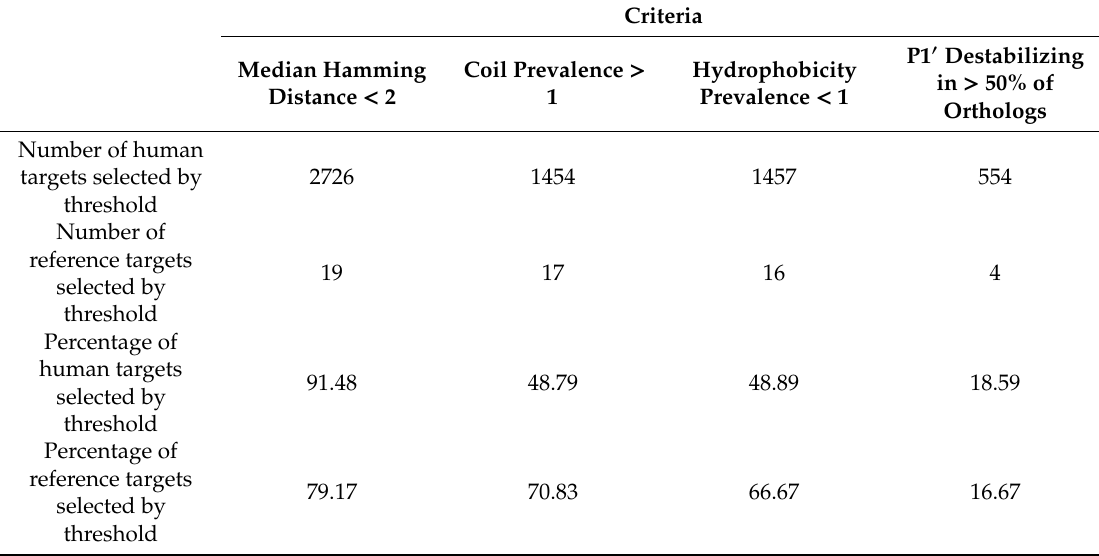
Table 4. Validation of conservation criteria based on the set of reference caspase targets with proven proapoptotic activity